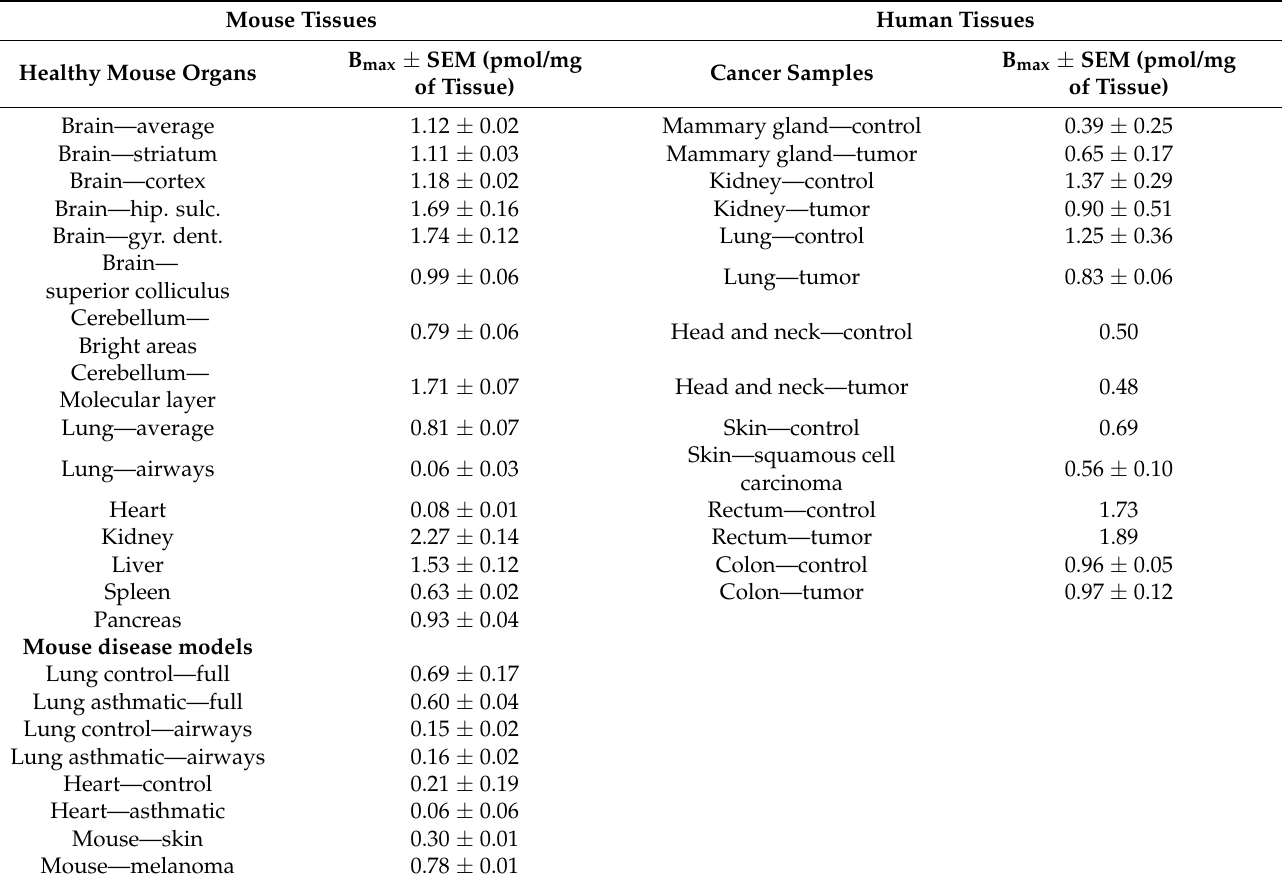
Table 1. B max values (pmol of G α q/11 proteins per mg tissue) obtained from autoradiography experiments in different mouse